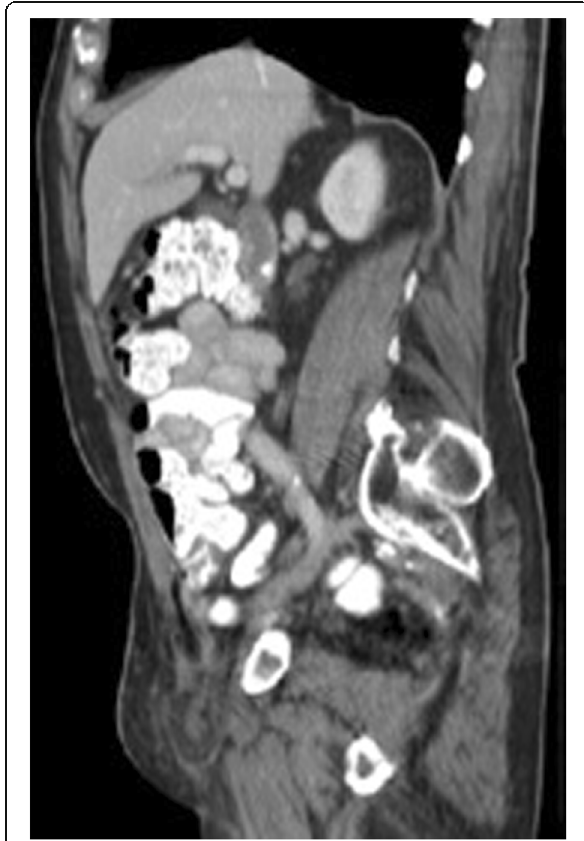
Fig. 1 Computed tomography sagittal view of the appendix and omentum within the